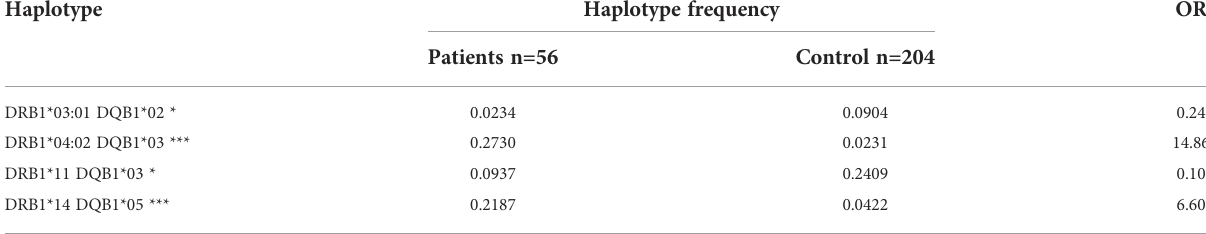
TABLE 5 HLA-DRB1-DQB1 haplotypes associated with pemphigus vulgaris in the Bulgarian population. Haplotype